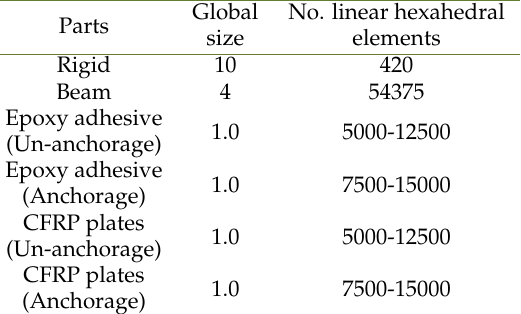
Table 3. Details of meshing in ABAQUS CEA